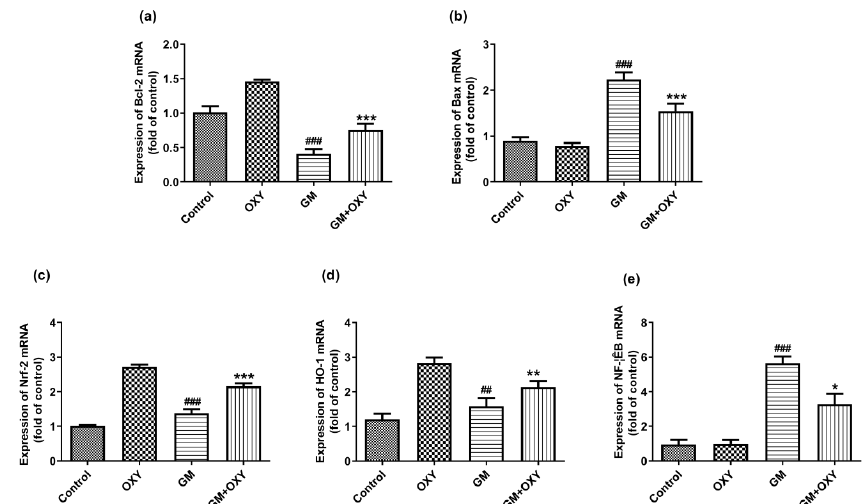
Figure 4. Effect of oxymatrine on GM-induced expression of Bcl-2 ( a ), Bax ( b ), Nrf-2 ( c ), HO-1 ( d ) and NF- κ B ( e ) mRNAs in the kidneys. Data are presented as mean ± SD ( n = 10). * p < 0.05, ** p < 0.01 and *** p < 0.001 compared to the control group; ## p < 0.01 and ### p <0.001, compared to the GM treatment group.